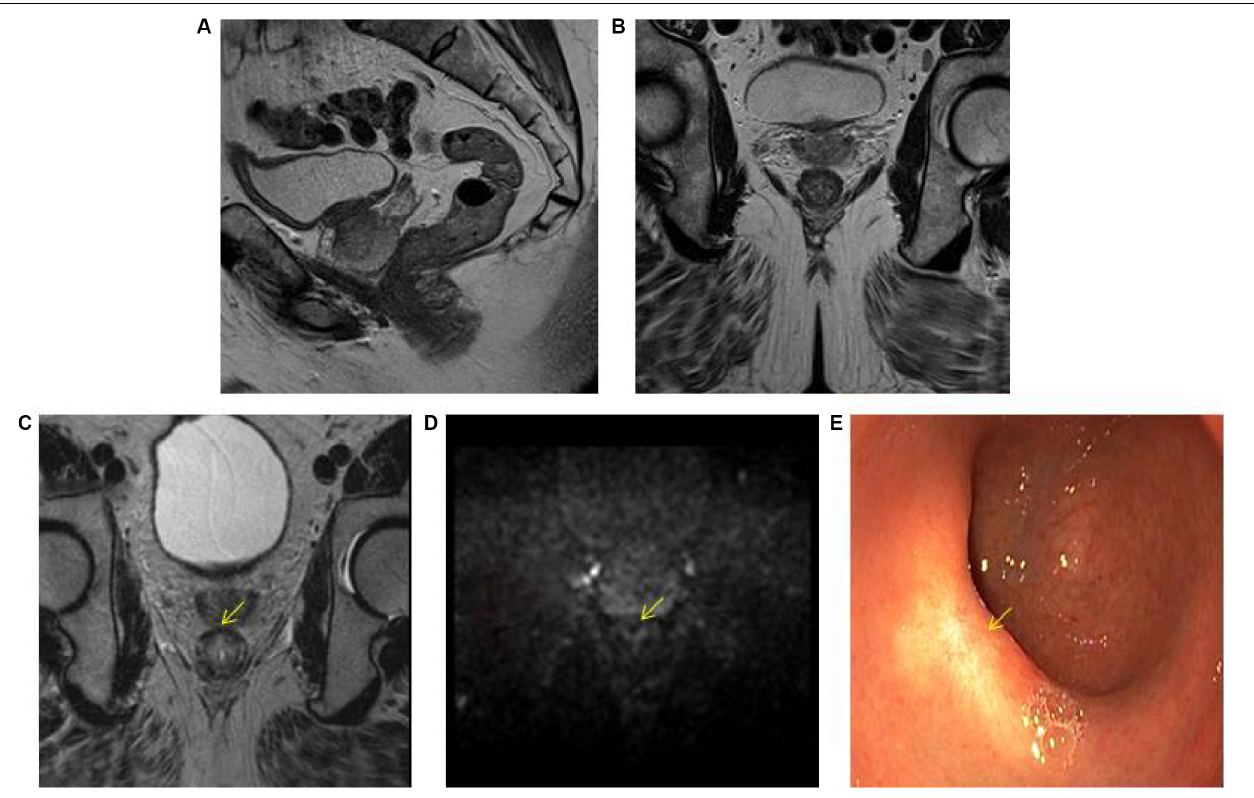
FIGURE 1 | Three-modality approach with combination of T2W-MRI, DWI, and endoscopy of the selection of a patient with a clinical complete response. A low rectal tumor is seen on MRI (A, B) . On restaging MRI 8 weeks after completion of chemoradiotherapy (C) only minimal fibrosis (yellow arrow) is seen anteriorly in the rectal wall. On restaging DWI (D) there is absence of high diffusion signal (yellow arrow). Clinical assessment by endoscopy (E) reveals a white scar with telangiectasia (yellow